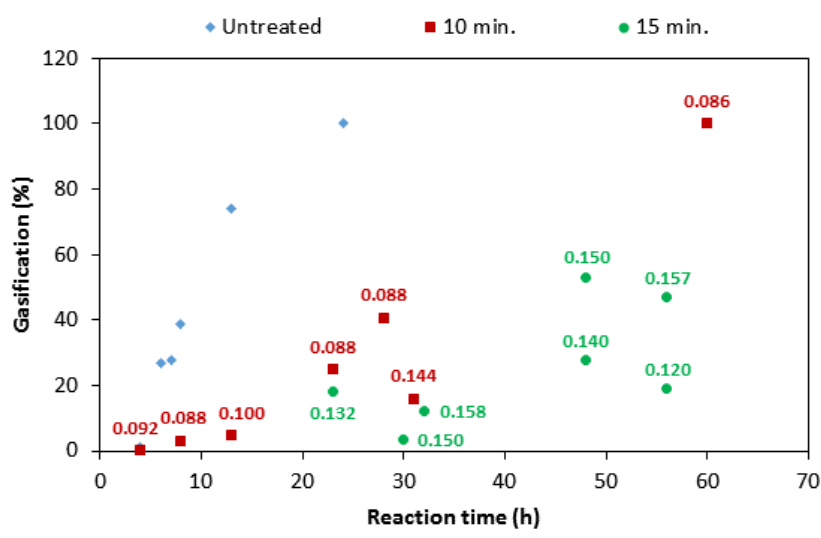
Figure 6. Gasification vs. reaction time during gasification for a series of samples with different boron loading.